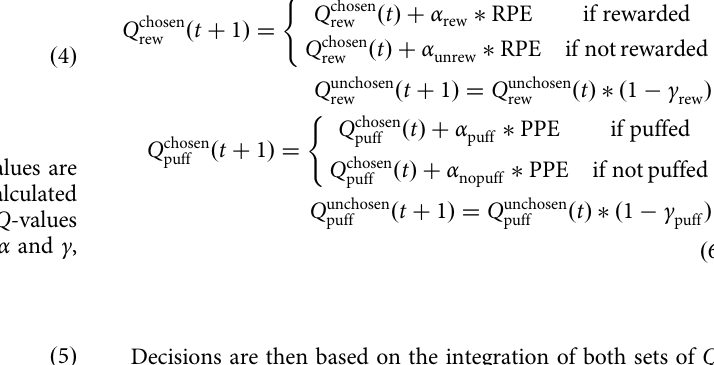
values (Eq. (7)), weighted by β rew and β puff to allow for differences